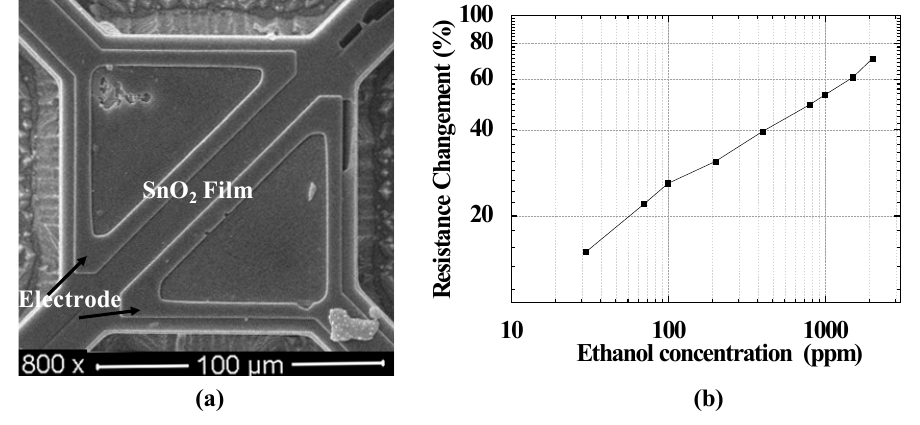
Figure 7. Microhotplate platform configured as a metal-oxide gas sensor with SnO 2 -sensitive film and the response to ethanol. ( a ) Scanning electron microscope (SEM) picture of the tungsten microhotplate for metal-oxide gas sensor; ( b ) Response of metal-oxide gas sensor to ethanol with different concentrations at 300 °C.